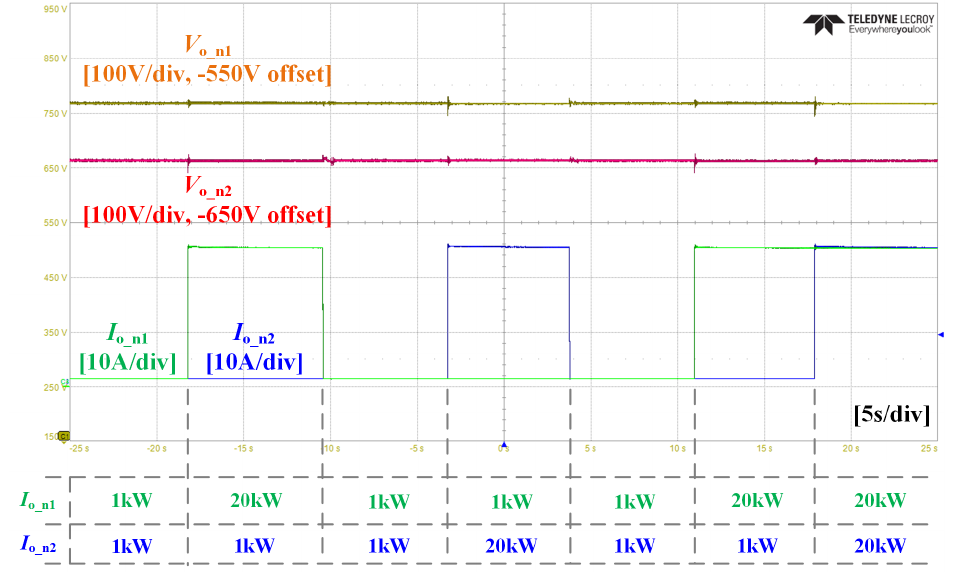
Figure 17. The decoupling waveform of the TAB converter when the loads of each port are changed at a random timing ( n is the subunit index, n = 1 ∼